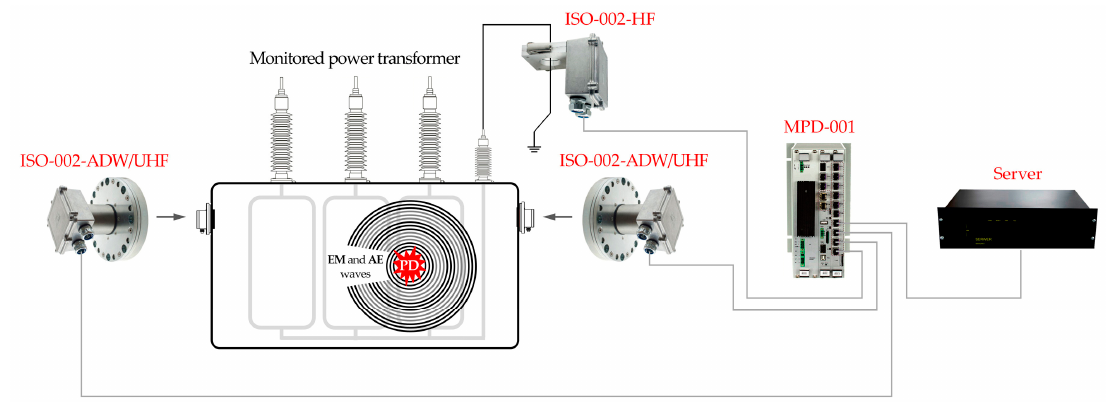
Figure 1. Schematic diagram of the general structure of the developed on-line partial discharges monitoring system for power monitoring system for power transformers.